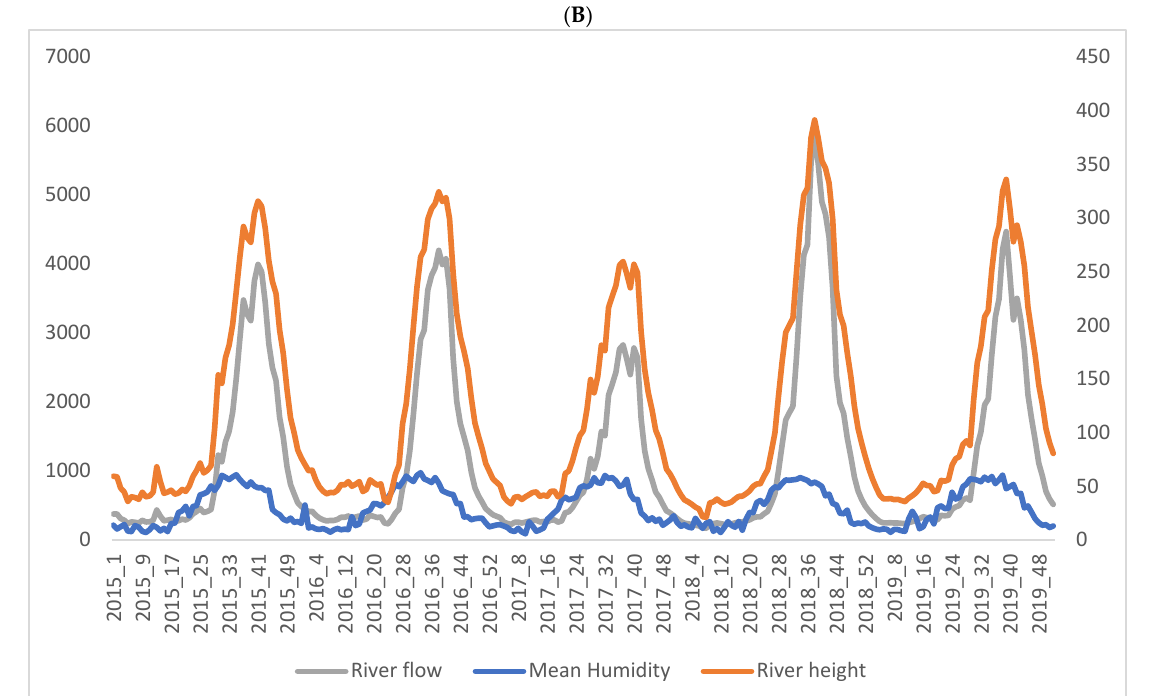
Figure 1. ( A ): Weekly malaria incidence (red curve) according to rainfall (blue), temperature (or- ange), and transmission period (PrdTrans: white band — low transmission period; grey band — high transmission period). ( B ): River height (orange curve), river flow (gray curve), and relative humidity (blue curve).